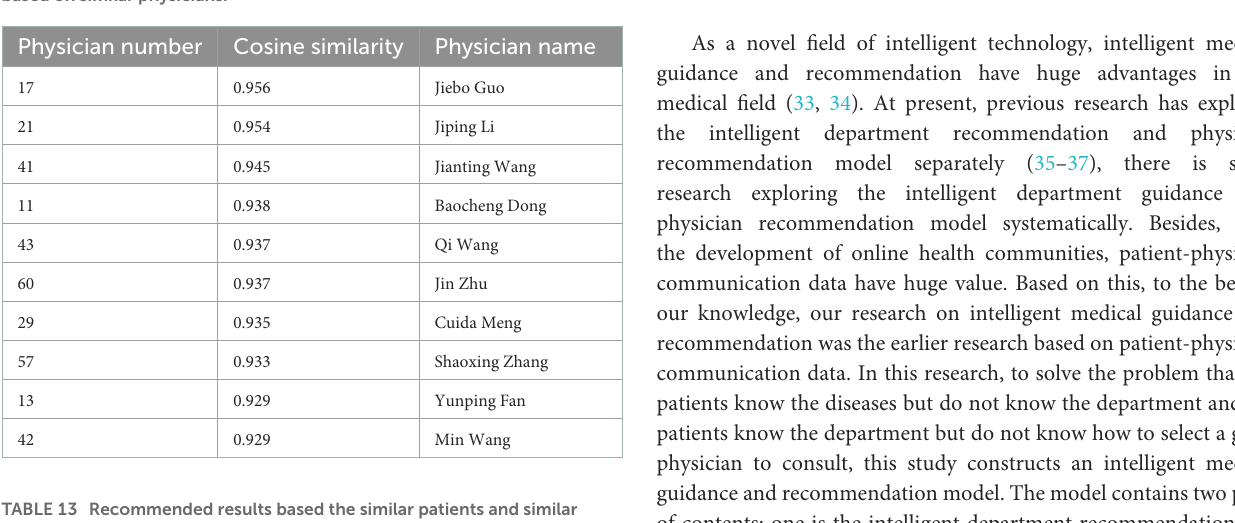
TABLE 12 One hundred and twenty target patient recommendation results based on similar physicians.